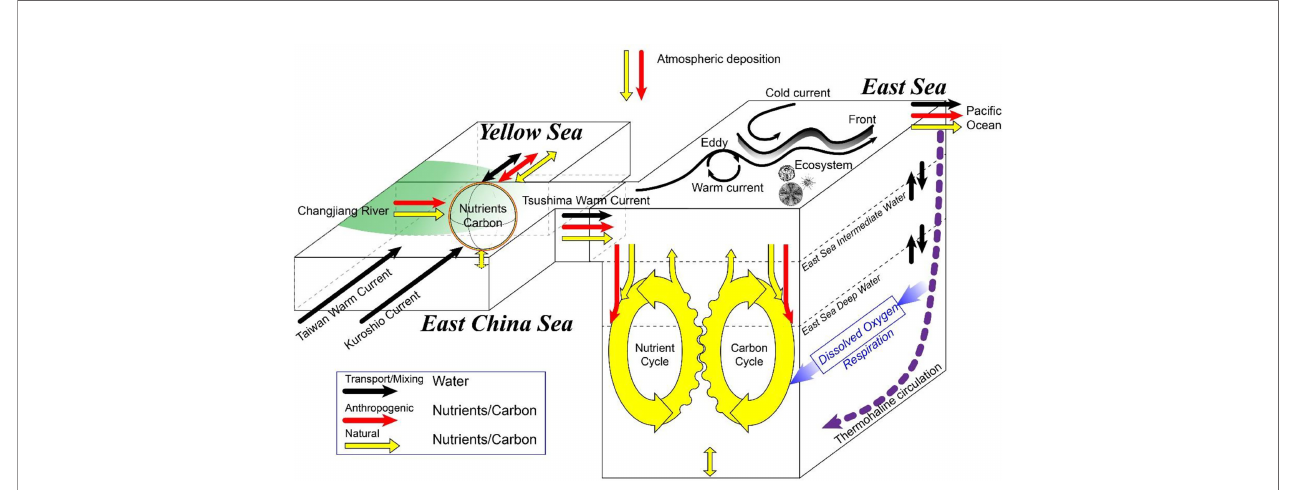
FIGURE 1 | A diagram showing the transport patterns of water, nutrients, and carbon in the East Asian marginal seas, including deep water formation and the cycling of nutrients and carbon in the deep East Sea (Japan